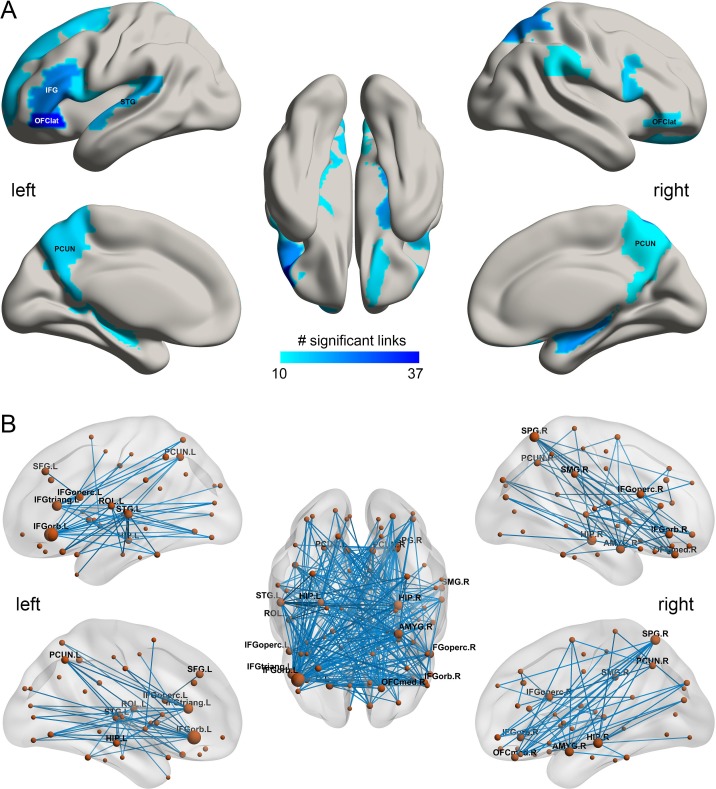
The smoking associated functional connectivities.(A) The AAL2 areas with different functional connectivity (measured by the number of significant links FDR p<0.005) involving that area, using a threshold of 10 links for the smoking compared to the non-smoking group. IFG – inferior frontal gyrus; OFClat –lateral orbitofrontal cortex; PCUN – precuneus; STG – superior temporal gyrus. (B) Significant links (FDR p<0.005) between the AAL2 areas with blue showing a decrease for the smoking group compared to the non-smoking group. The left hemisphere is on the left of each brain diagram in this and other Figures.10.7554/eLife.40765.010Figure 2—source data 1.All significant links (FDR p<0.05) between the AAL2 areas for the smoking group.